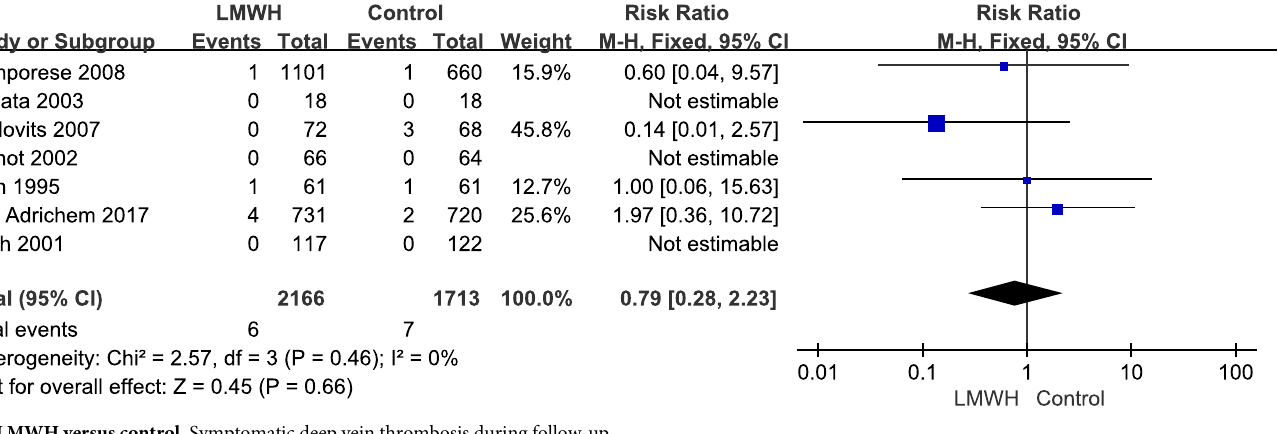
PLOS ONE | https://doi.org/10.1371/journal.pone.0197868 June 21,